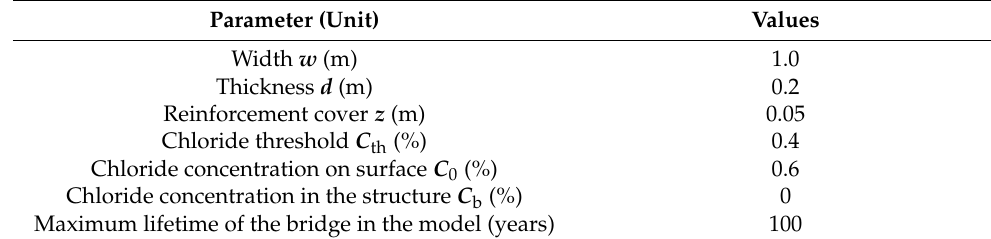
Table 1. Input parameters for numerical models [25].